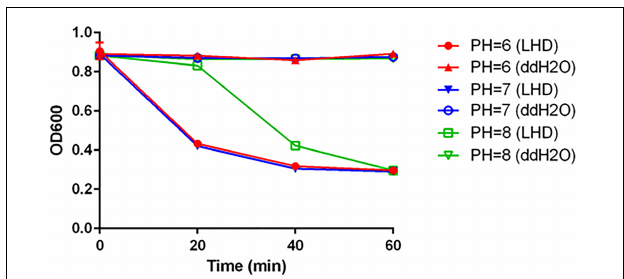
FIGURE 4 | Lytic activity of LHD on C. difficile R20291 in different pH conditions. Prior to tests, bacterial optical density at 600 nm (OD 600 ) was adjusted to approximately 0.8–1.0. Protein LHD was added into the cell re-suspension with the final concentration of 200 µ g/ml. The drop in OD 600 at 37 ◦ C was measured once per 20 min for 60 min. Bacterial re-suspension with sterilized water was also set as a control. Data are present as “Mean ± SD”. Experiments were repeated 3 times, and representative data were shown.